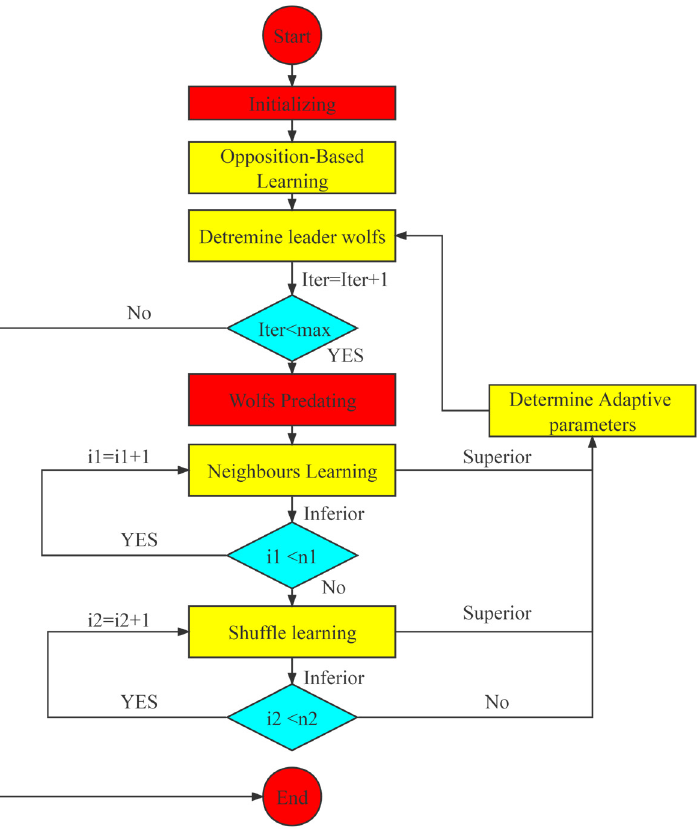
Figure 9. Flow of MSGWO .